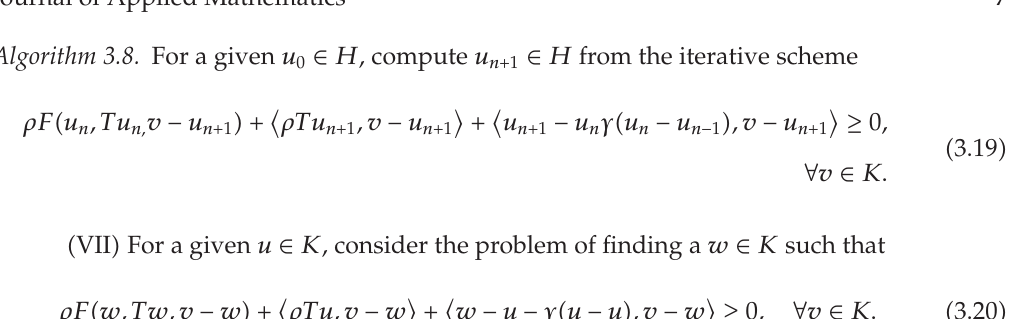
Algorithm 3.8. For a given u 0 ∈ H , compute u n (cid:7) 1 ∈ H from the iterative scheme